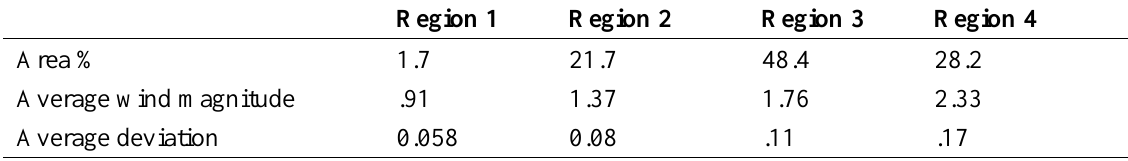
Table 2 . The statistical characteristics of wind magnitude classes Region